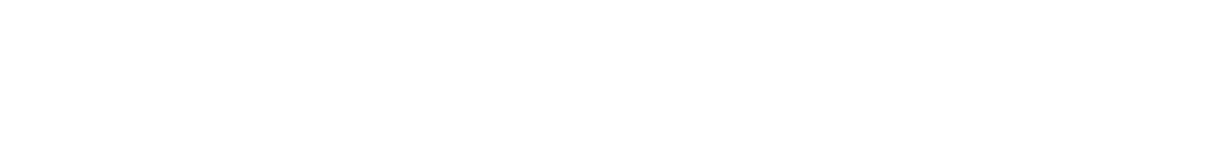
Frontiers in Chemistry |